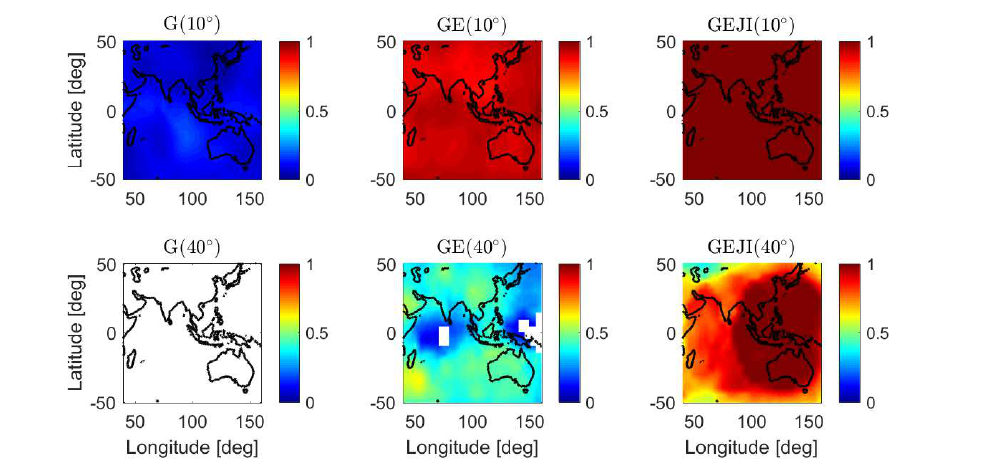
Figure 8. Mean formal IB ASRs for short baselines from 40 ◦ E to 160 ◦ E and from 50 ◦ S to 50 ◦ N on DOY 224, 2018. The data sampling interval is 30